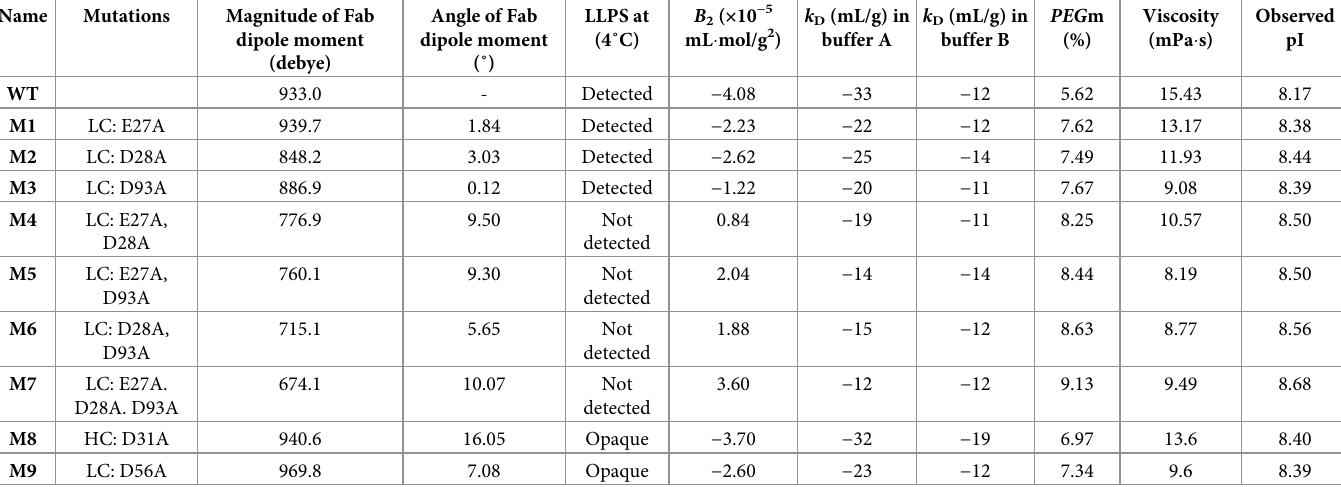
Table 1. Biophysical assessments using in silico and in vitro analysis of wild type (WT) and mutant (M) mAbs. Name